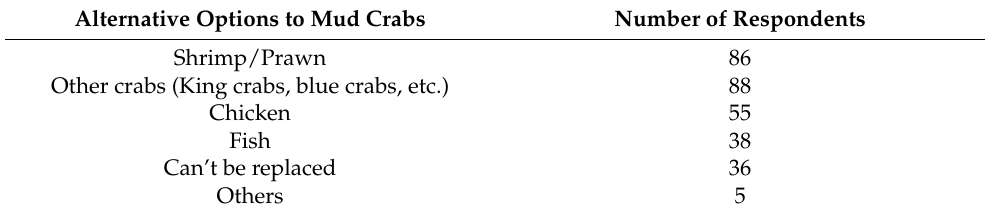
Table 8. Alternative to mud